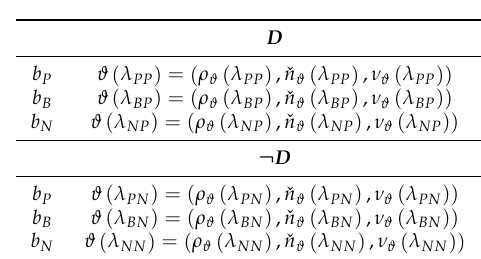
Table 3. The loss function matrix with